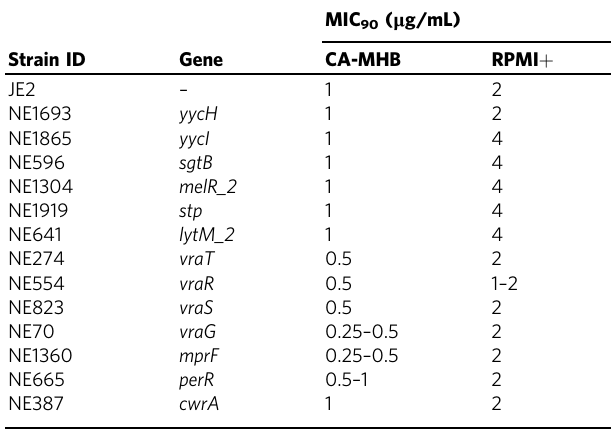
Table 1 Minimum inhibitory concentration (MIC 90 ) of selected strains from the S. aureus Nebraska Transposon Mutant Library 63 in both environmental conditions, CA- MHB and RPMI +